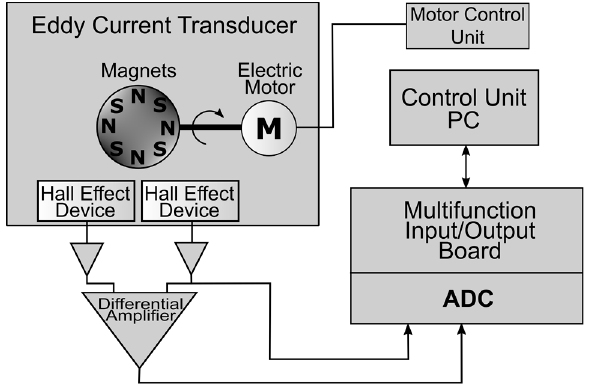
Figure 2. Block scheme of the measuring system.